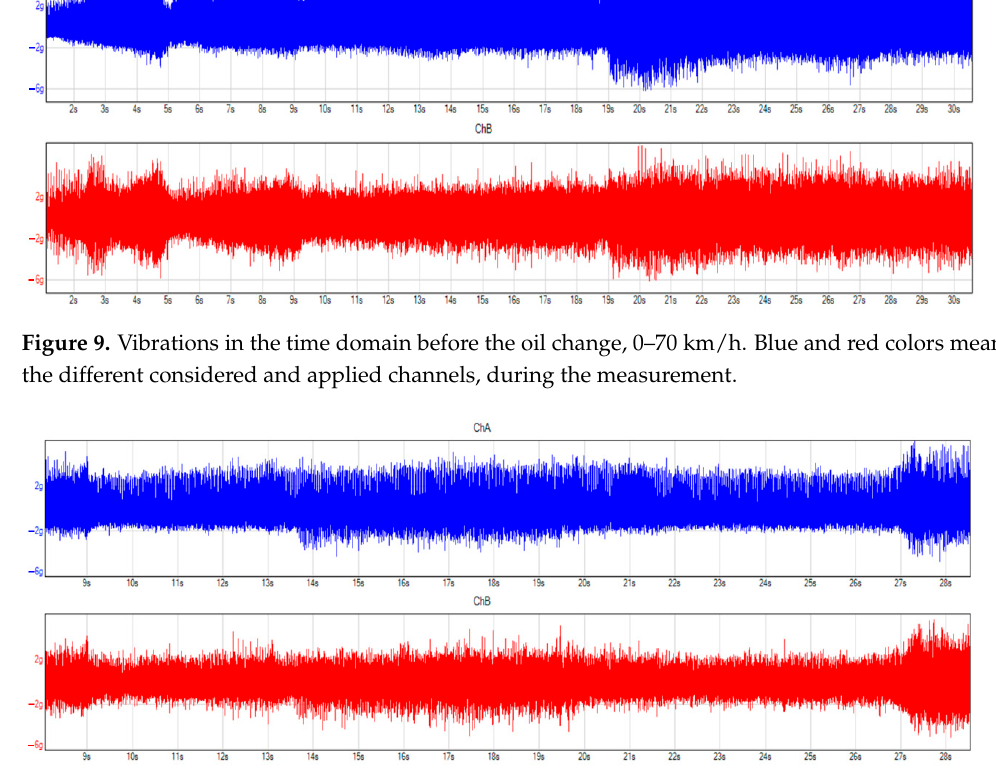
Figure 10. Vibrations in the time domain after the oil change, 0–70 km/h. Blue and red colors mean the different considered and applied channels, during the measurement.